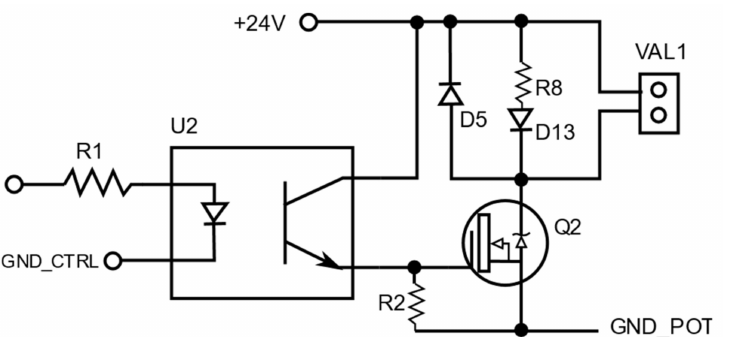
Figure 7. Simple control scheme of a proportional valve